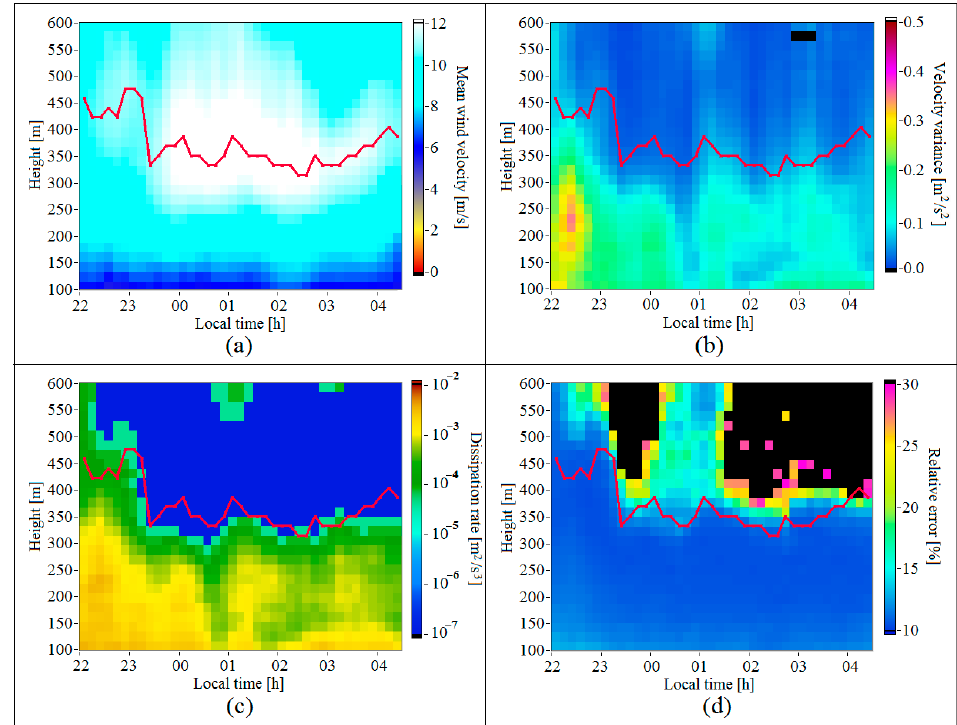
Figure 6. Height–temporal distributions of the mean wind velocity ( a ), variance of the vertical component of the wind velocity vector ( b ), turbulent energy dissipation rate ( c ), and relative error of lidar estimation of the dissipation rate ( d ) starting from 21:45 LT on 10 July 2020. The red curve shows the time series of the height of the maximum of mean velocity.